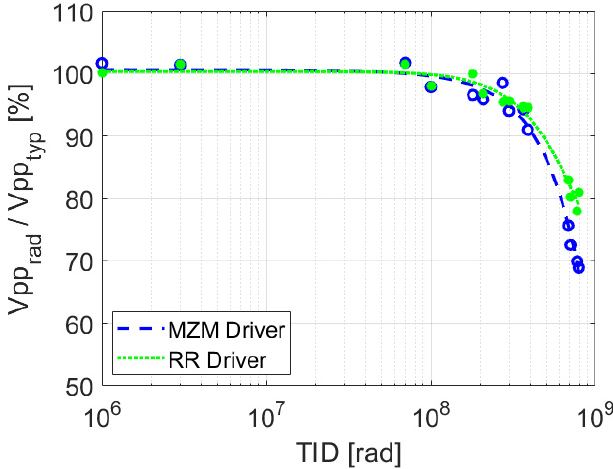
Figure 7 . Degradation of the output voltage eye diagram amplitude as a function of TID for the two drivers. The points represent the performed measurements for different TID levels, and the dotted-dashed lines are their trend curves.